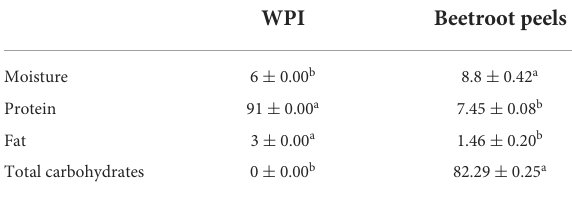
TABLE 1 Proximate composition of whey protein isolate (WPI) and beetroot peels expressed on dry basis in